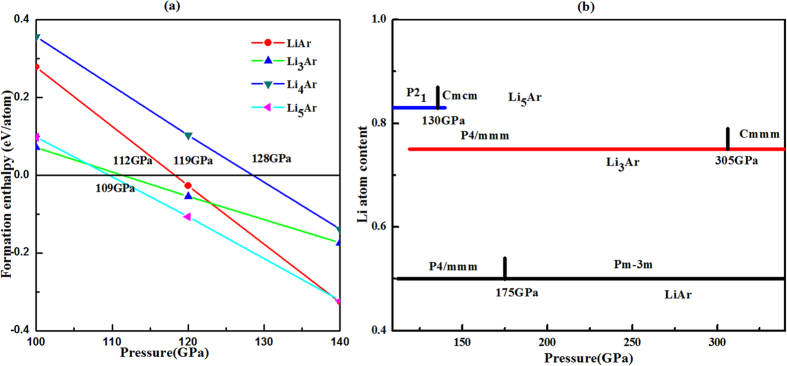
(a) Enthalpy of formation as a function of pressure for various LimAr compounds, respectively, where ΔH(LimAr) = H(LimAr)-m*H(oC24-Li)-H(hcp-Ar); (b) Predicted pressure ranges of stability for Li-Ar compounds.